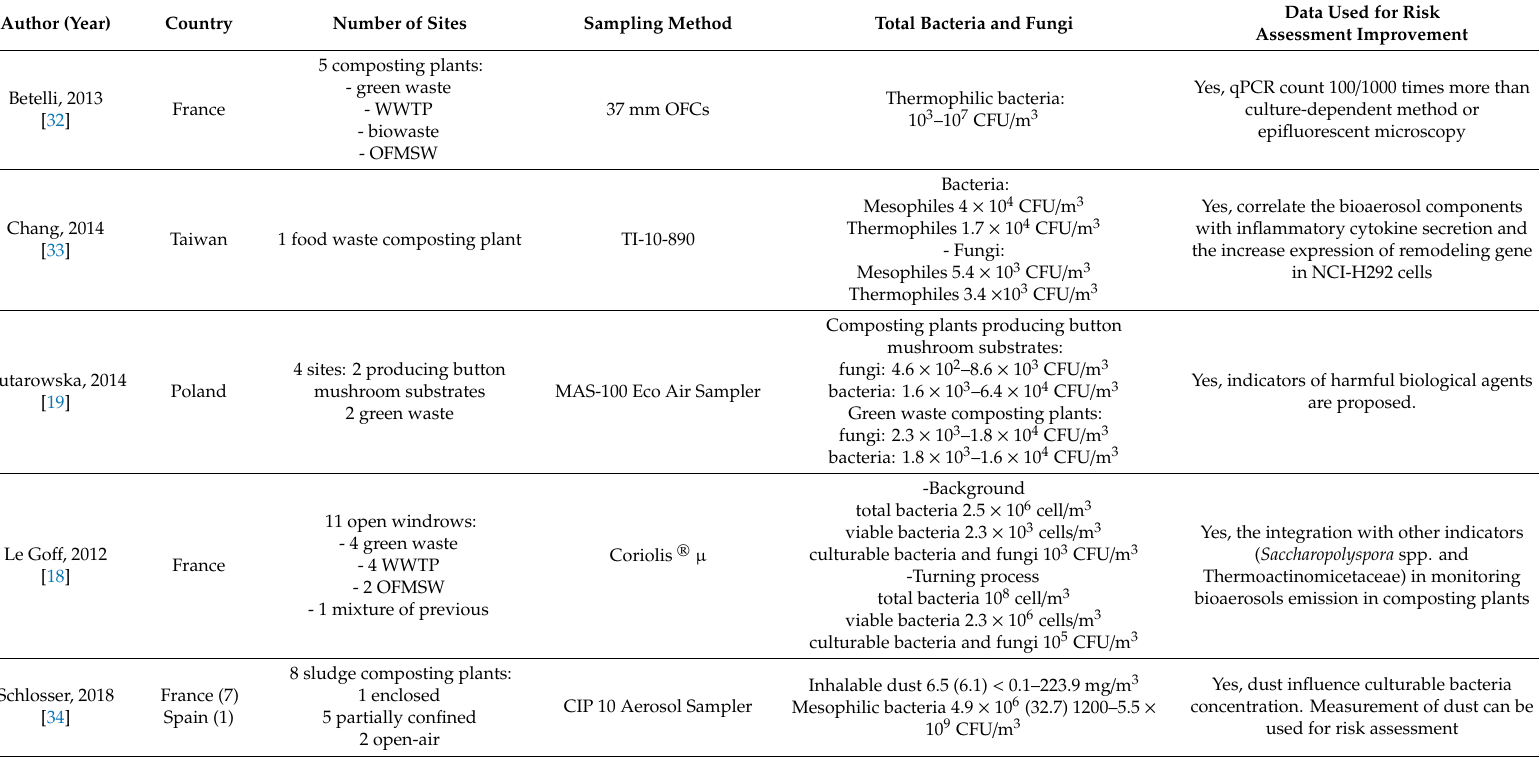
Table 1. Bioaerosol studies in organic waste treatment plants (OWTPs) that presented total bacteria and / or fungi